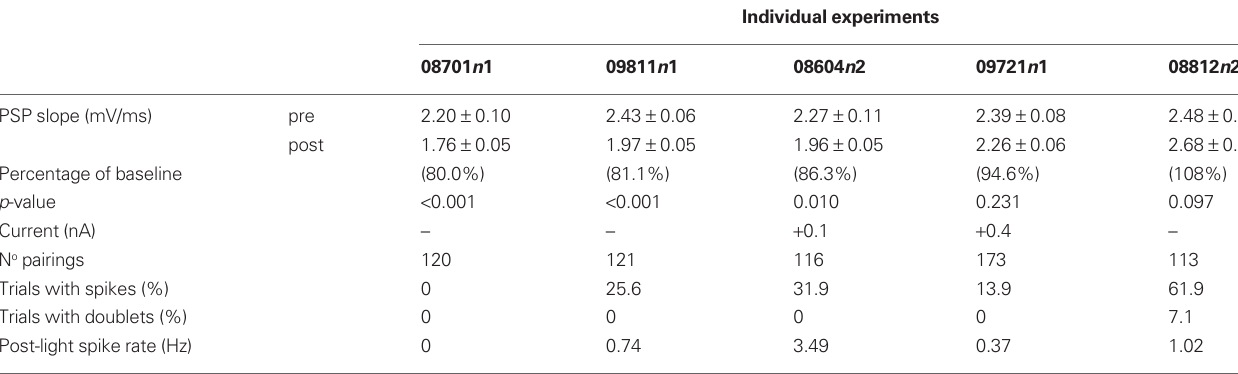
Table 2 | Summary of results from pairing single cortical stimuli followed by